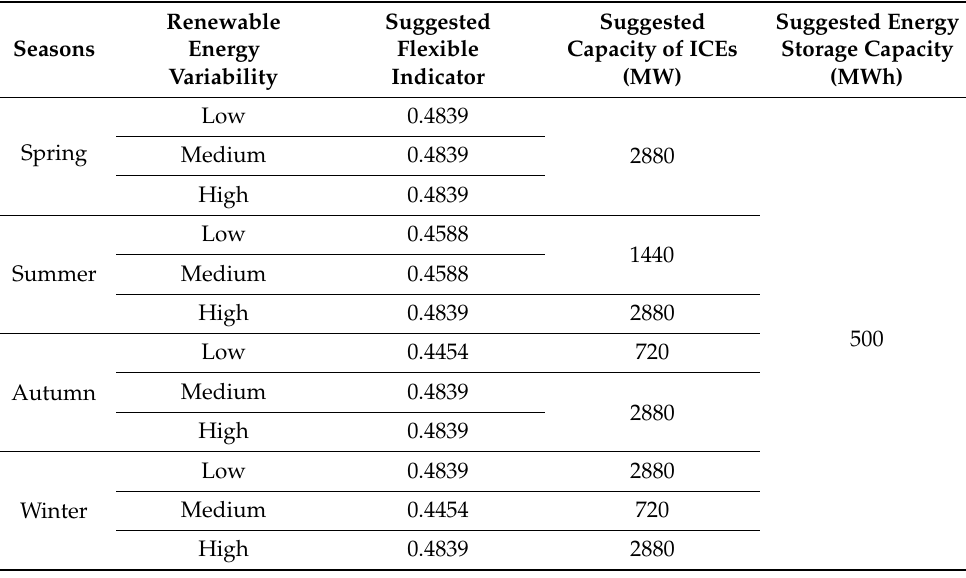
Table 4. Simulation results in four